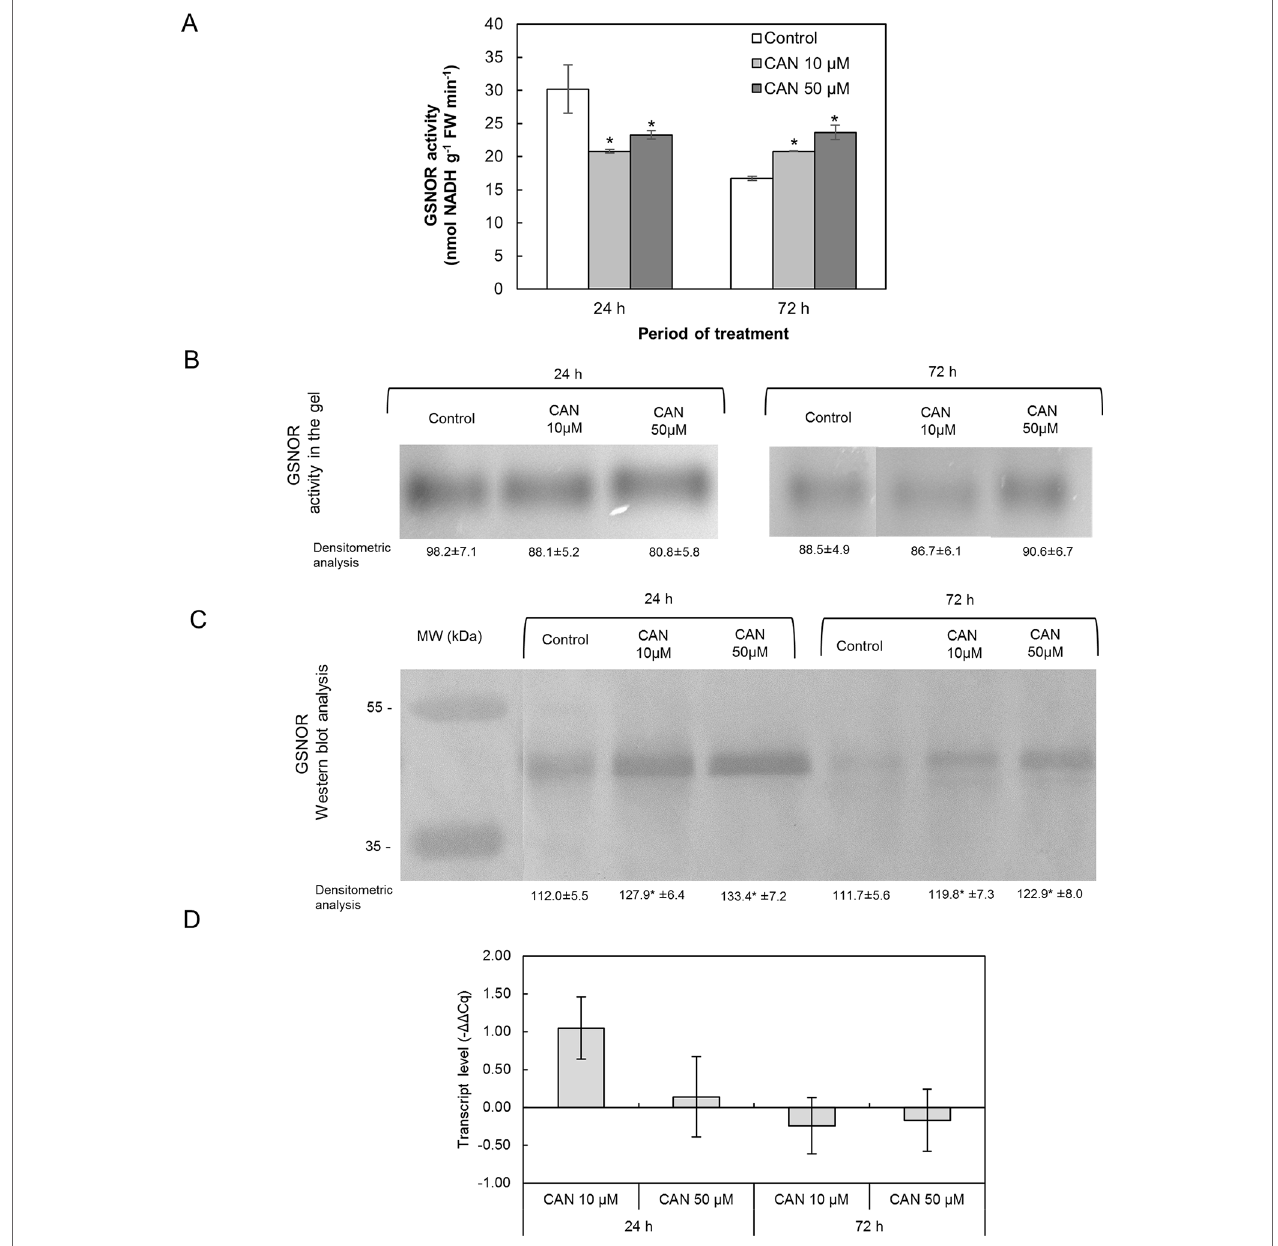
FIGURE 6 | Activity of GSNOR determined in extracts using spectrophotometric assay (A) , visualization of GSNOR activity in the gel (B) , GSNOR protein (C) and transcript level of GSNOR (D) in roots of tomato seedlings growing in water (control) or treated with CAN (10 or 50 µM) after 24 or 72 h of culture period. Asterisk (*) indicates significance from control at the same time of culture period at P ≤ 0.05, based on Student’s test. Values are average ± SD of at least three independent experiments and three biological repetitions